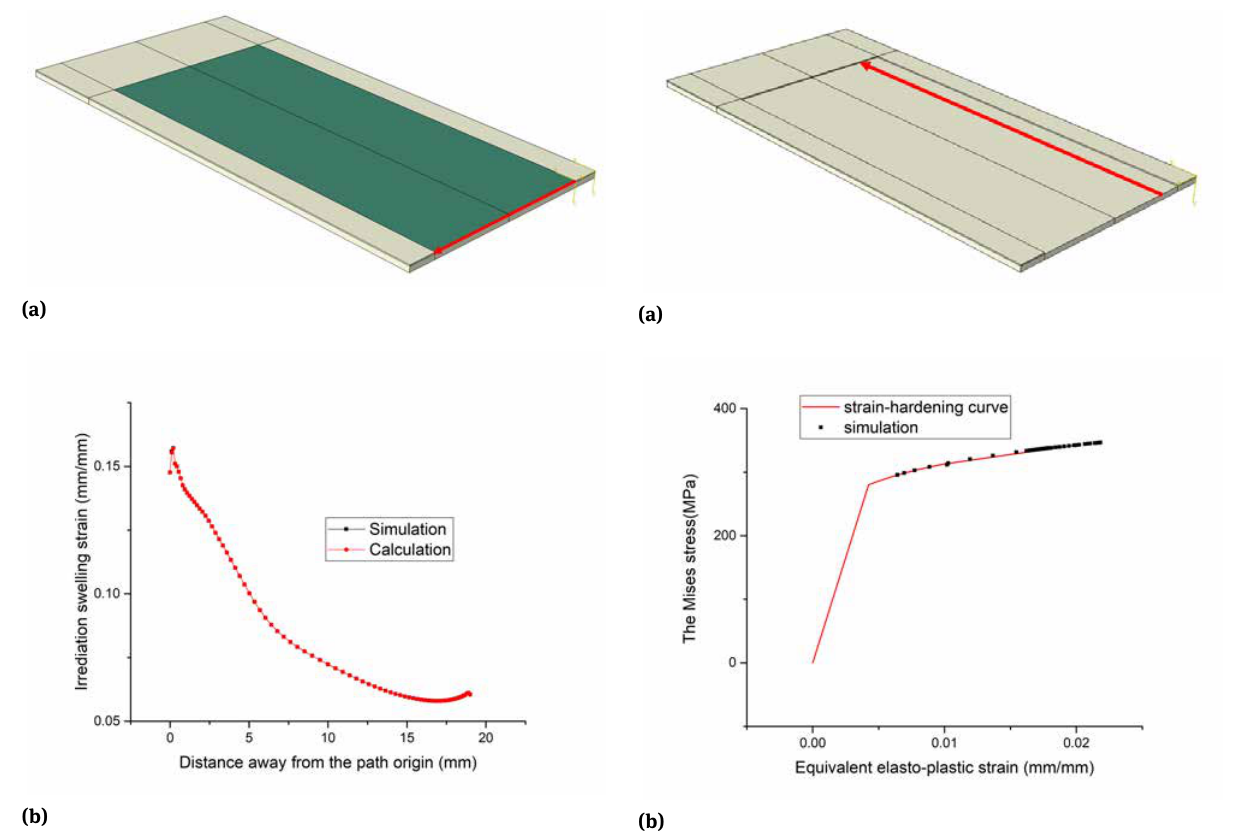
Figure 9: Verification of plasticity constitutive relation Simultaneously, it is confirmed that the calculation of the deviatoric stresses is